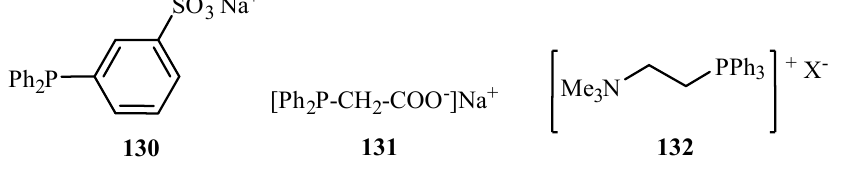
Figure 17. Water ‐ soluble phosphines reviewed by Genet and Savignac [62]. Figure 17. Water-soluble phosphines reviewed by Genet and Savignac